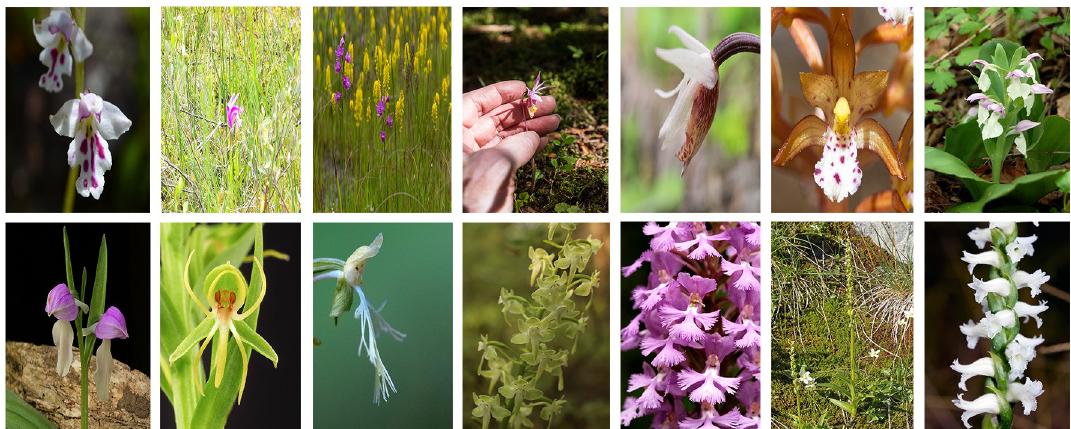
Fig 6. A selection of pictures of orchids in the dataset used in our